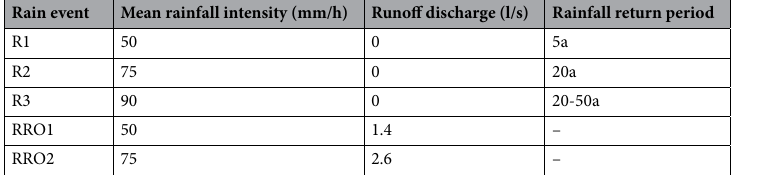
Table 1. Five rain